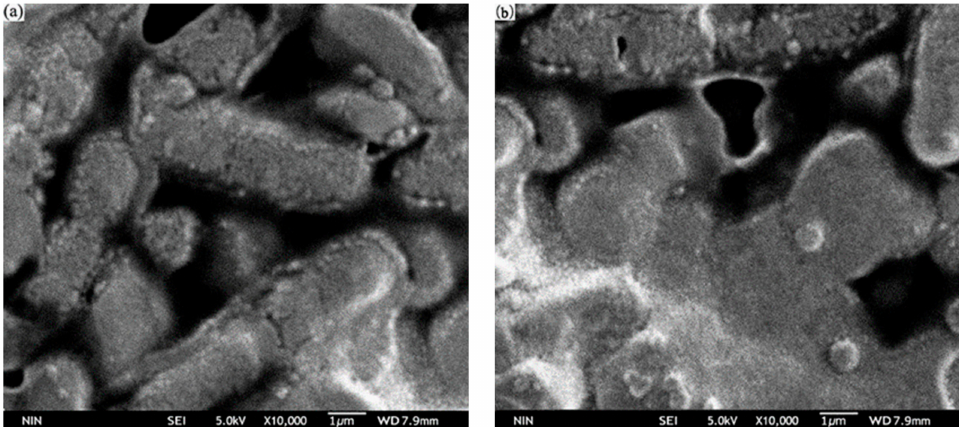
Figure 5. SEM pictures of E. coil ( a ) control; ( b ) treated under 100 W power, 60 s time, 40 cm 3 · min − 1 gas flow rate and 45 Pa